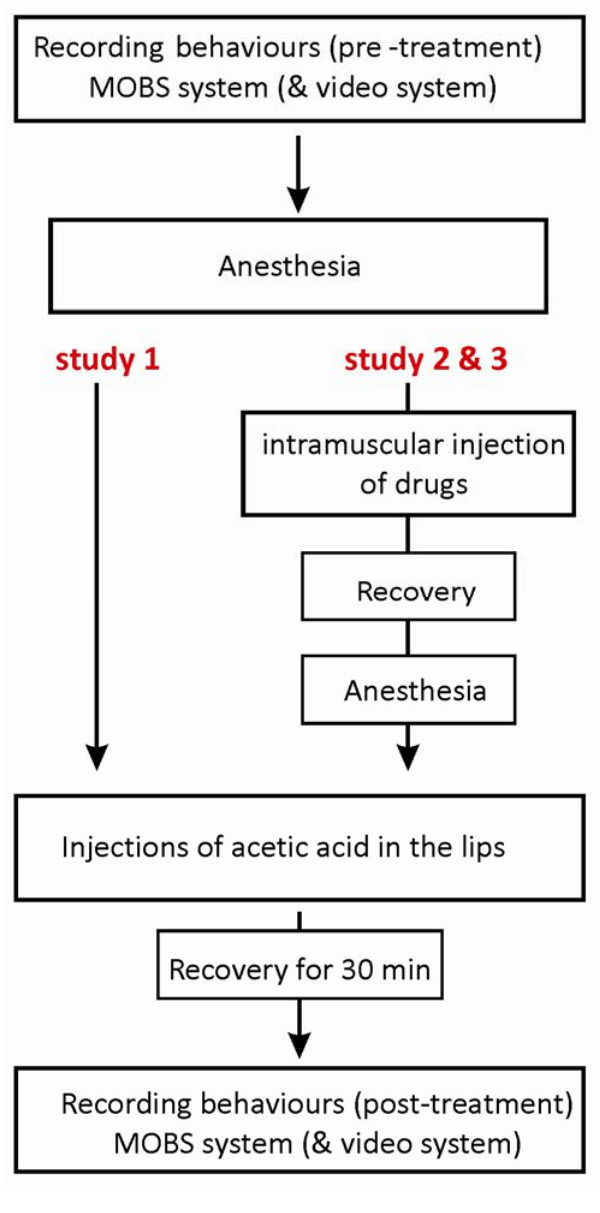
Figure 1. Experimental study